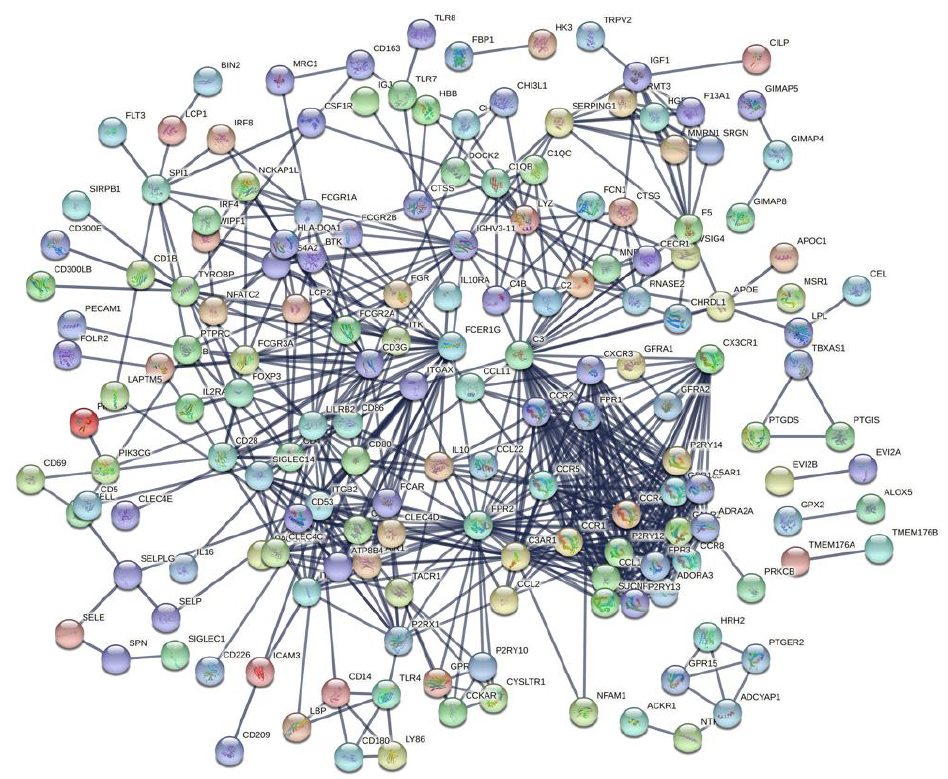
Figure 5. The protein – protein interaction (PPI) analysis of DEGs based on the immune and stromal scores in OSCC patients. The interaction nodes, scores > 0.95 were set as the cutoff to the PPIs network.